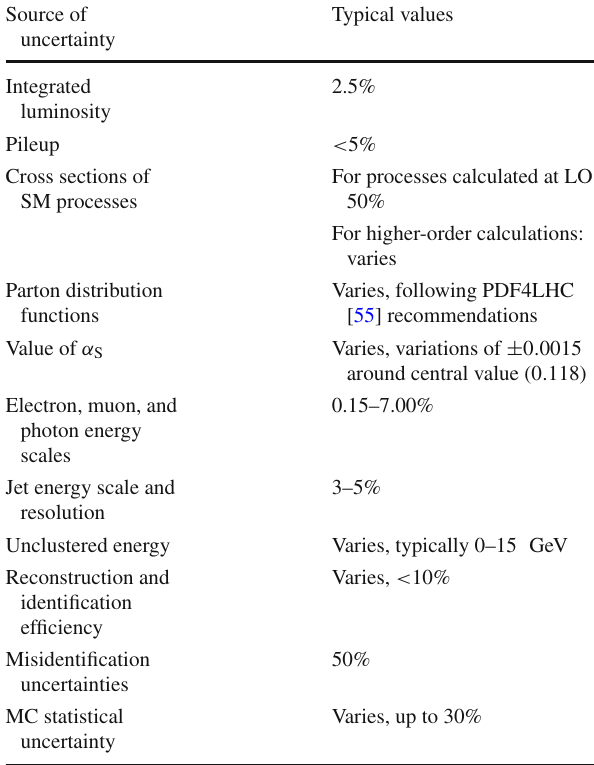
Table 4 Summary of systematic uncertainties in the